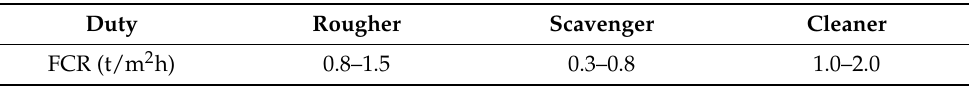
Table 1. FCR rates for a bank of mechanical flotation cells, which is used as a rule of thumb by industry